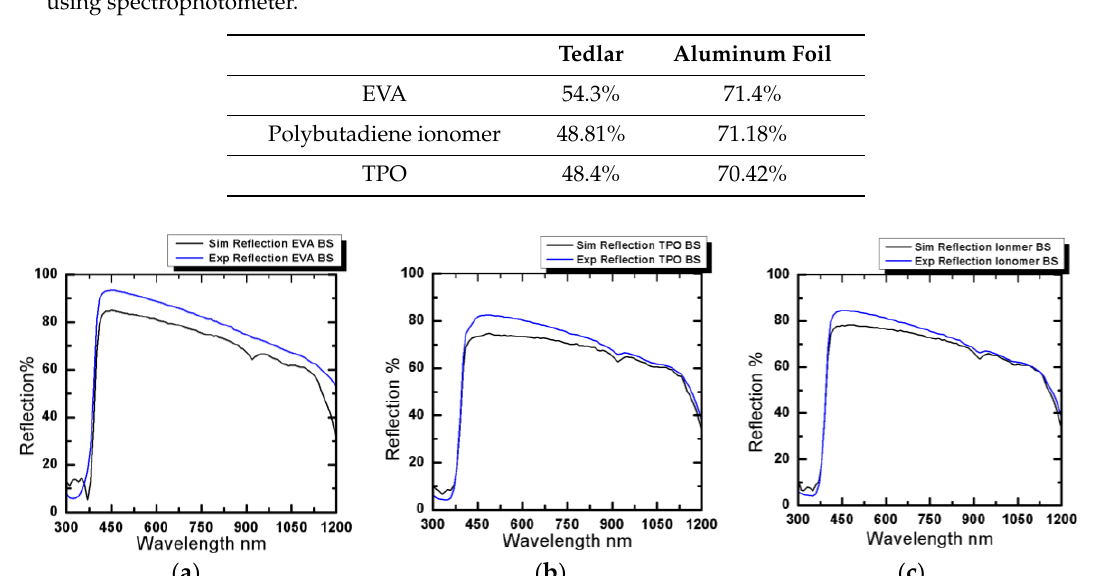
Figure 4. Reflection along the light spectrum using Tedlar as back sheet for ( a ) ethylene vinyl acetate (EVA), ( b ) thermoplastic polyolefin (TPO), and ( c ) polybutadiene ionomer.